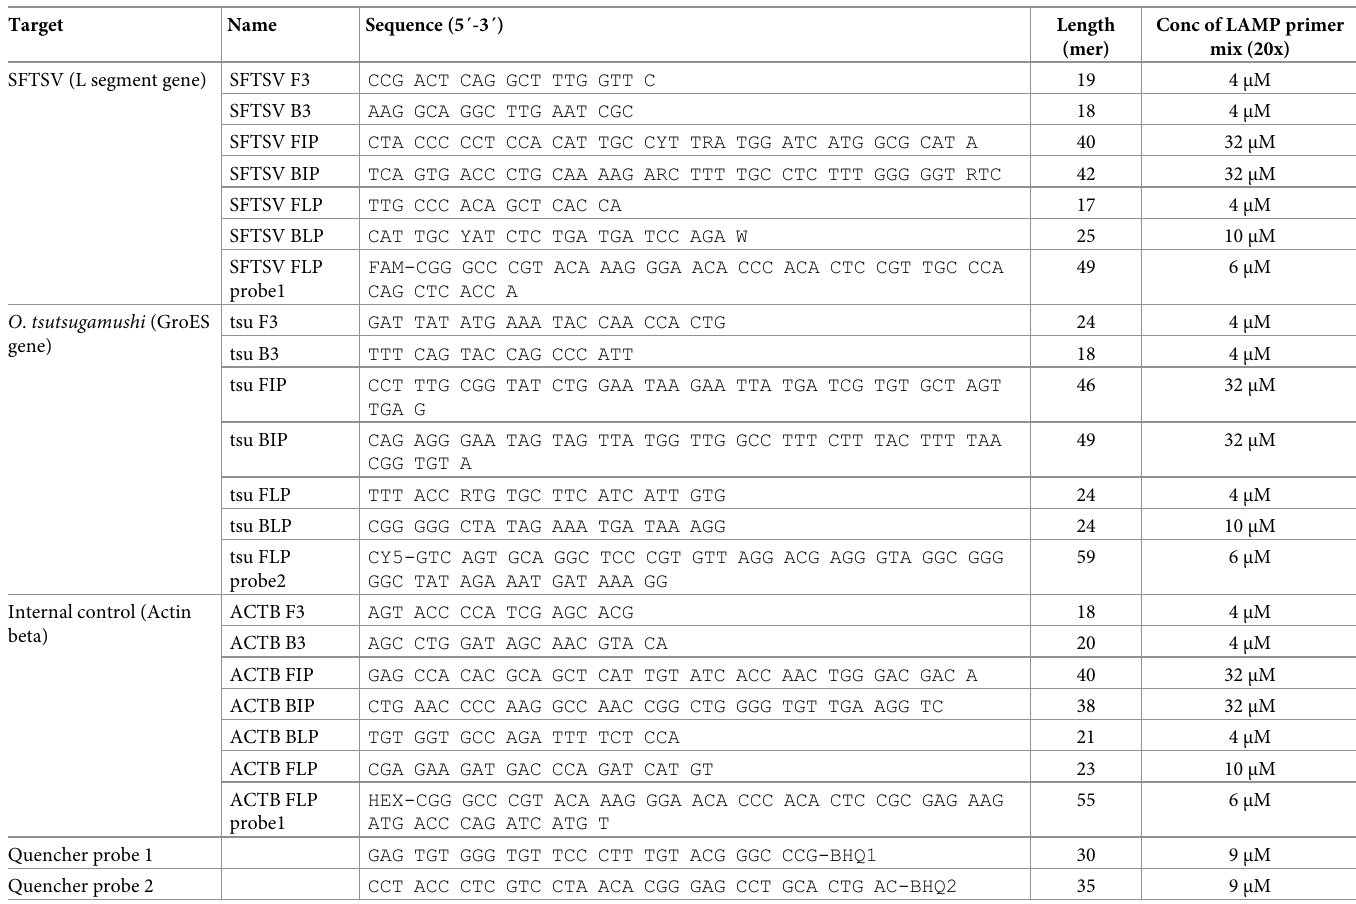
Table 1. The multiplex SFTSV/OT/IC RT-LAMP primer